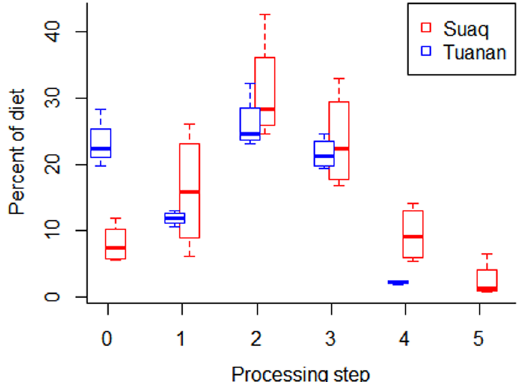
Figure 7. Percentage of the different processing steps in the diets of 4 adult females at Suaq and Tuanan